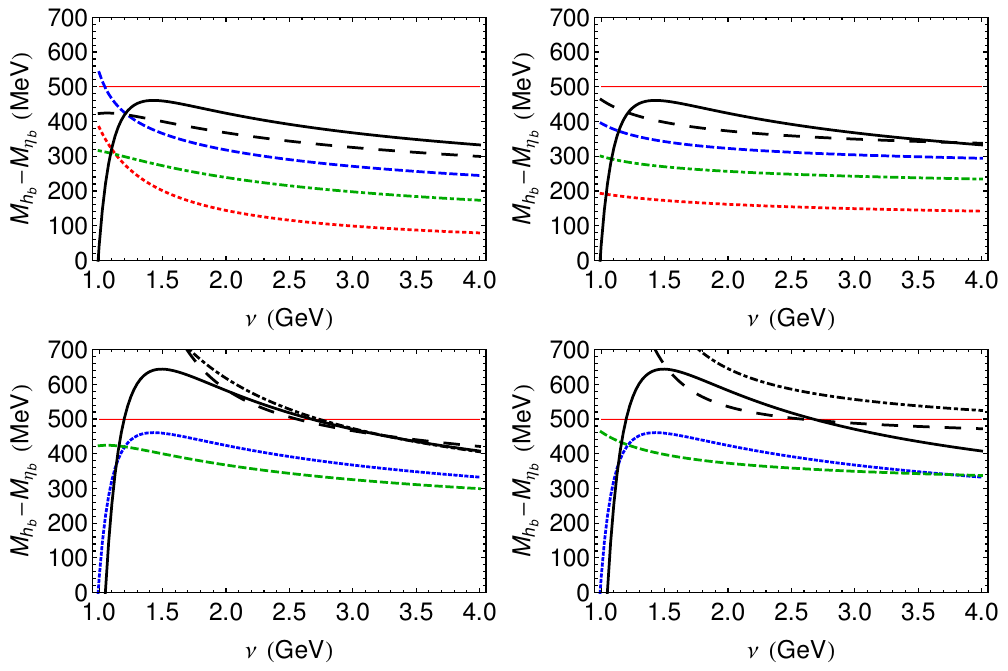
Figure 11 . Plot of M h (cid:0) M (cid:17) in MeV in RS’ scheme for (cid:23) f = 1 GeV, m b; RS 0 = 4 : 885 GeV. Red b b band is the experimental value. Upper left panel: (cid:23) r = 1 GeV. Red dotted, green dot-dashed, blue dashed and black long-dashed are the results obtained solving eq. (4.1) with the static potential truncated at N=0,1,2,3, respectively. Solid black line is the N = 3 previous result in strict (cid:12)xed- order perturbation theory. Upper right panel: as in the upper left panel but with (cid:23) r = 1 GeV. Lower left panel: (cid:23) r = 1 GeV. Blue dotted line corresponds to the solid black line of the above (cid:12)gure, green short-dashed line corresponds to the long-dashed black line of the above (cid:12)gure. The other lines incorporate the relativistic and ultrasoft corrections. Solid black line is the full result in strict (cid:12)xed-order perturbation theory (solid black line in the left panel in (cid:12)gure 7). The long-dashed black line corresponds to eq. (4.7) evaluating the relativistic corrections with the wave function obtained solving the Schroedinger equation with the N = 3 static potential. The dot-dashed black line corresponds to eq. (4.7) evaluating the O ( mv 4 ) relativistic corrections with the wave function obtained from the N = 1 static potential and the O ( mv 4 (cid:11) s ) relativistic corrections with the wave function obtained from the N = 0 static potential. Lower right panel: as in the lower left panel but with (cid:23) r = 1